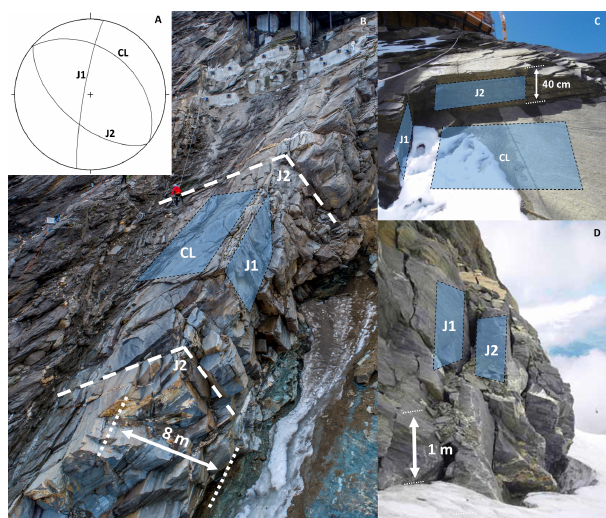
Figure 2. Dip and strike of the dominant discontinuities at the stud- ied rockwalls (A). Images of Kitzsteinhorn north face (KN) (B/C) and Magnetkoepfl east face (MKE) (D) with cleavage (CL) and joint sets (J1, J2) indicated. Cleavage of the calcareous mica schists dips about 45 ◦ NNE. Joint sets J1 (dipping subvertical to W) and J2 (dipping steeply to SW) are approximately orthogonal to CL and predispose north-facing slopes for dip-slope failures (B/C), while west- and east-facing areas are more susceptible to toppling failures (D) (photos: Robert Delleske (B), Andreas Schober (C,